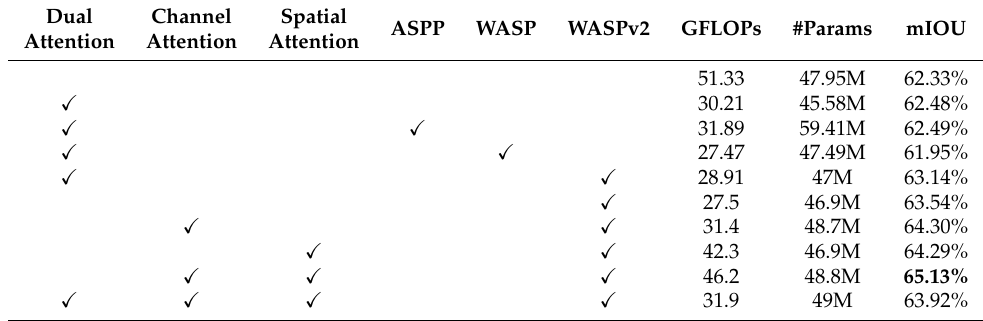
Table 2. Results of GourmetNet ablation experiments for various configurations on the UEC FoodPix dataset. The segmentation accuracy is indicated by the mIOU score, while the model complexity is described by the number of parameters and